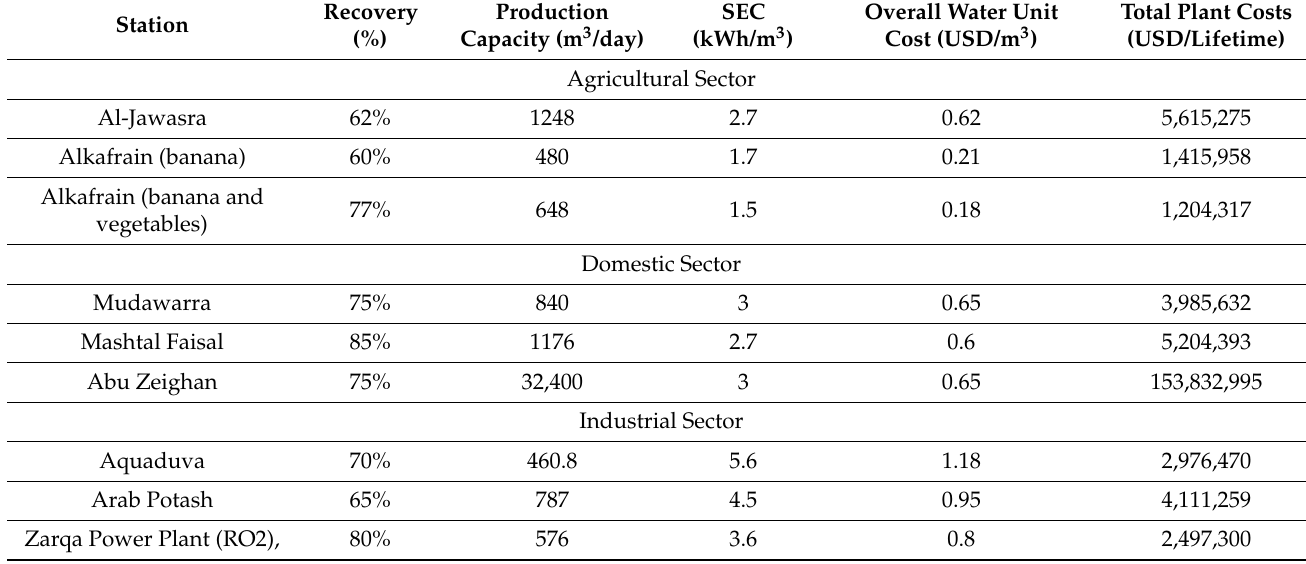
Table 5. Water and Energy Performance of the Assessed BWRO